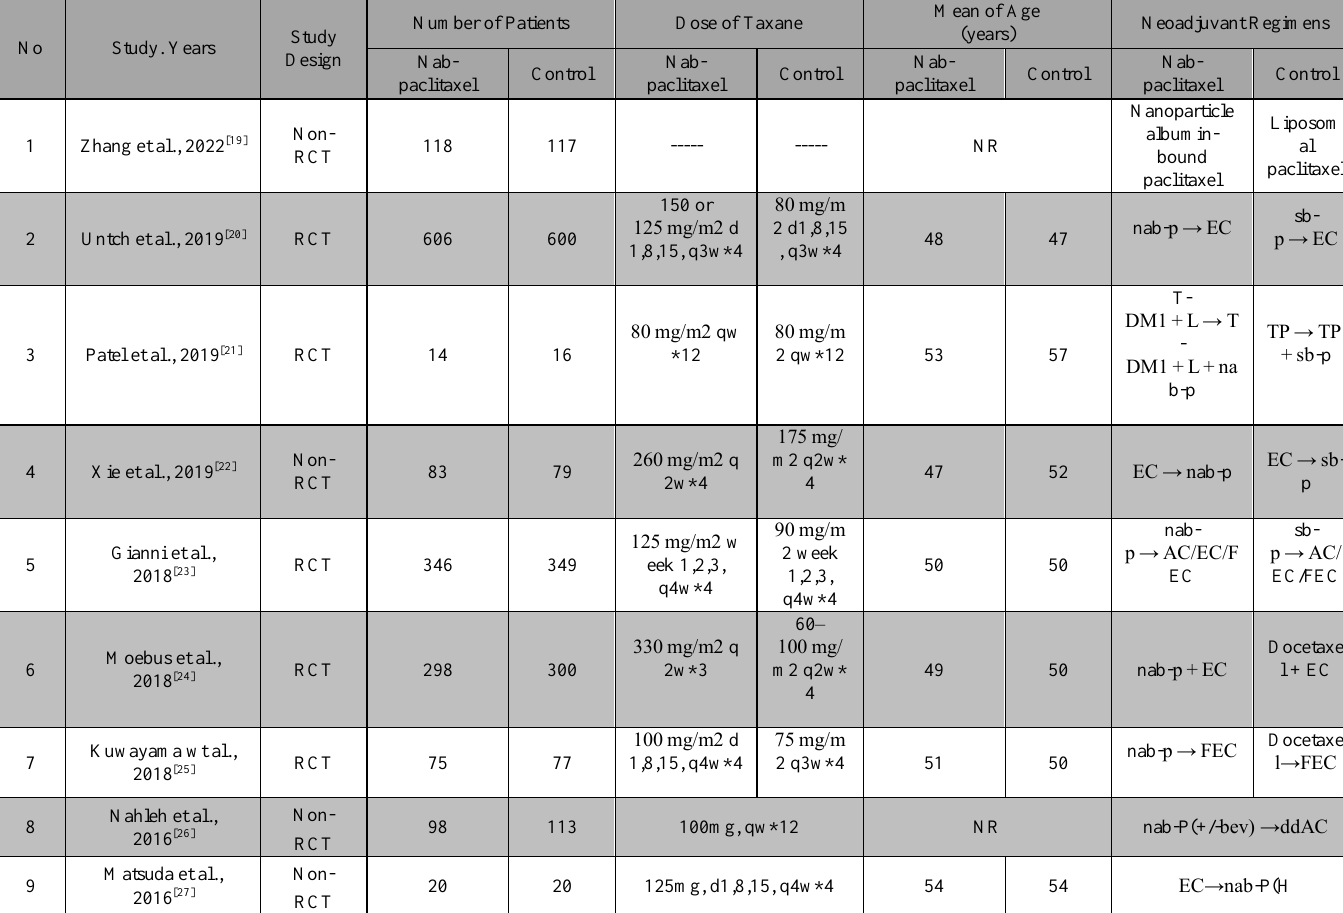
Table 2. Summary of demographic and clinical data of studies selected.